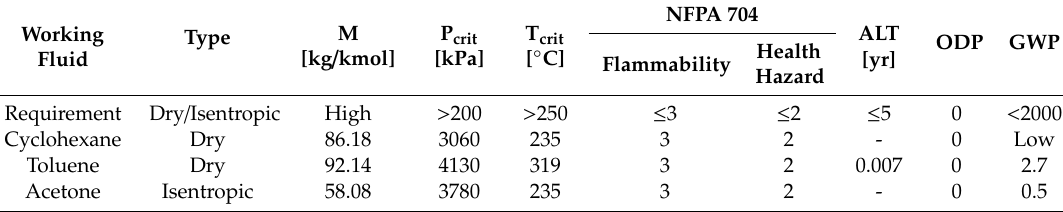
Table 2. Physical, chemical, and environmental properties of the selected